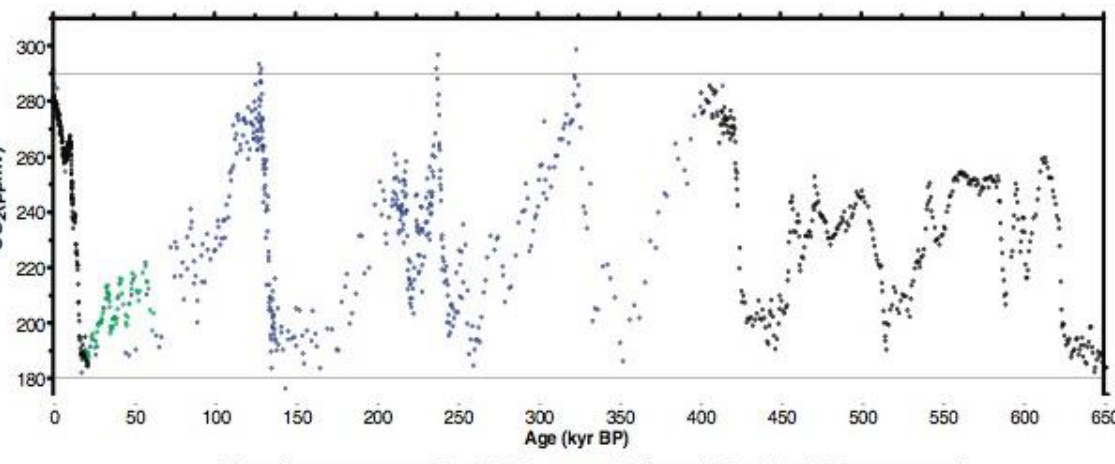
Figure 2. Fluctuations in CO2 levels in extracted ice